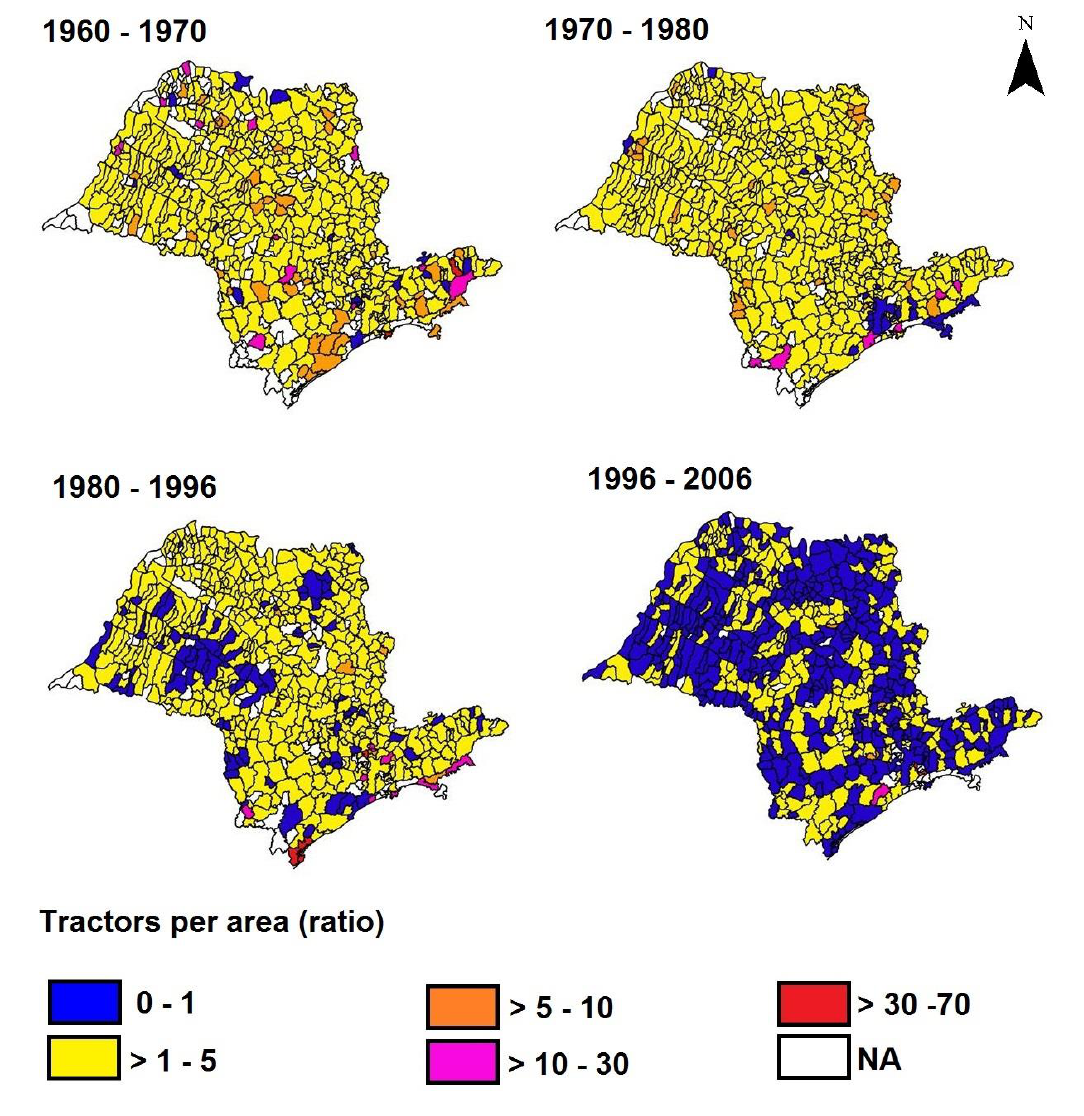
FIGURE A1.2 Tractors per area ratio at the municipality-scale for São Paulo state calculated for the intervals 1960-1970, 1970-1980, 1980-1996 and 1996-2006. The ratio of tractors per area was calculated by dividing the values of tractors per area of one census by the values of tractors per area of the previous census (e.g. values in 1970 / values in 1960). Ratio values greater than 1 (one) indicate that tractors per area increased over the census interval and values lower than 1 (one) indicate that it decreased. Municipality boundaries are shown in black. (NA) Missing